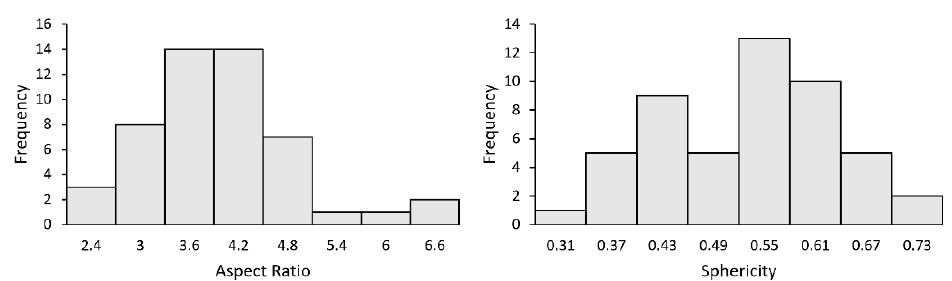
Figure 5. Aspect ratios and sphericity of the wood particles that were randomly selected from a slice within the labeled wood plastic composite sample.